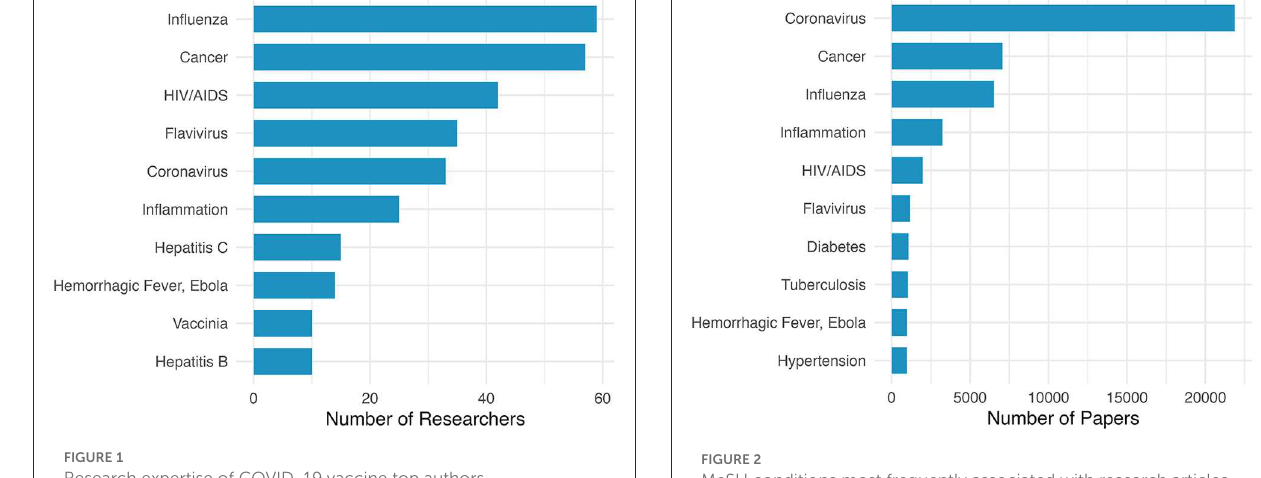
different efforts have drawn on their own research corpora that will